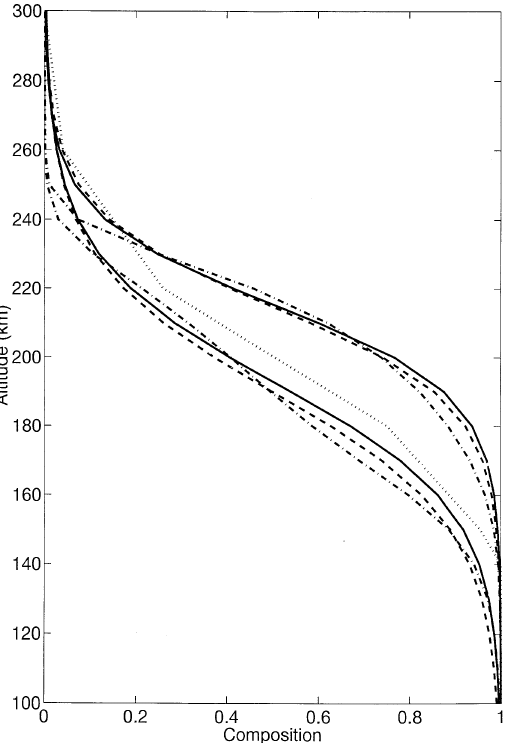
Fig. 1. Comparison between empirical composition models. Dotted line : EISCAT time-independent model. Dash - dotted lines : IRI model at midnight (below the EISCAT model) and at noon (above the EISCAT model). Dashed lines : Lathuille` re’s model. Solid lines : our